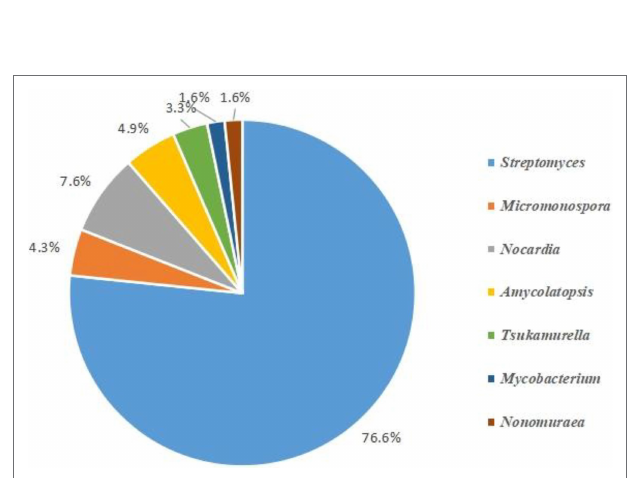
FIGURE 10 | Different genera of actinobacterial strains isolated by traditional culture-dependent